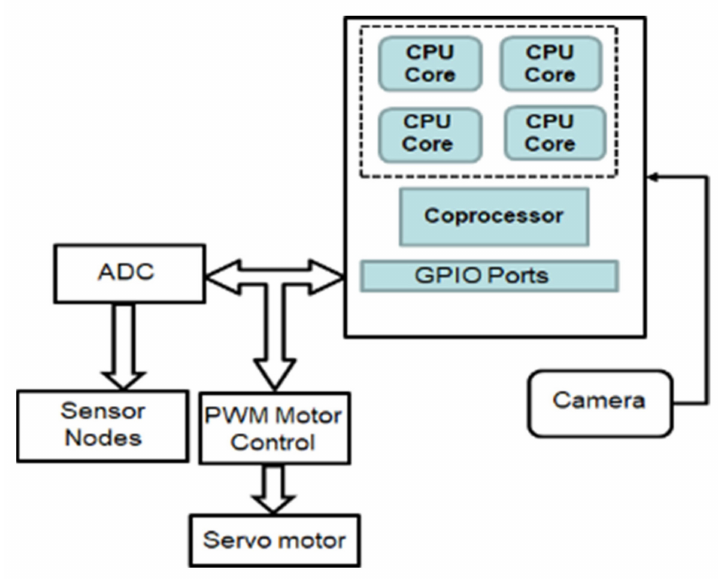
Figure 9. Simulated development platform.